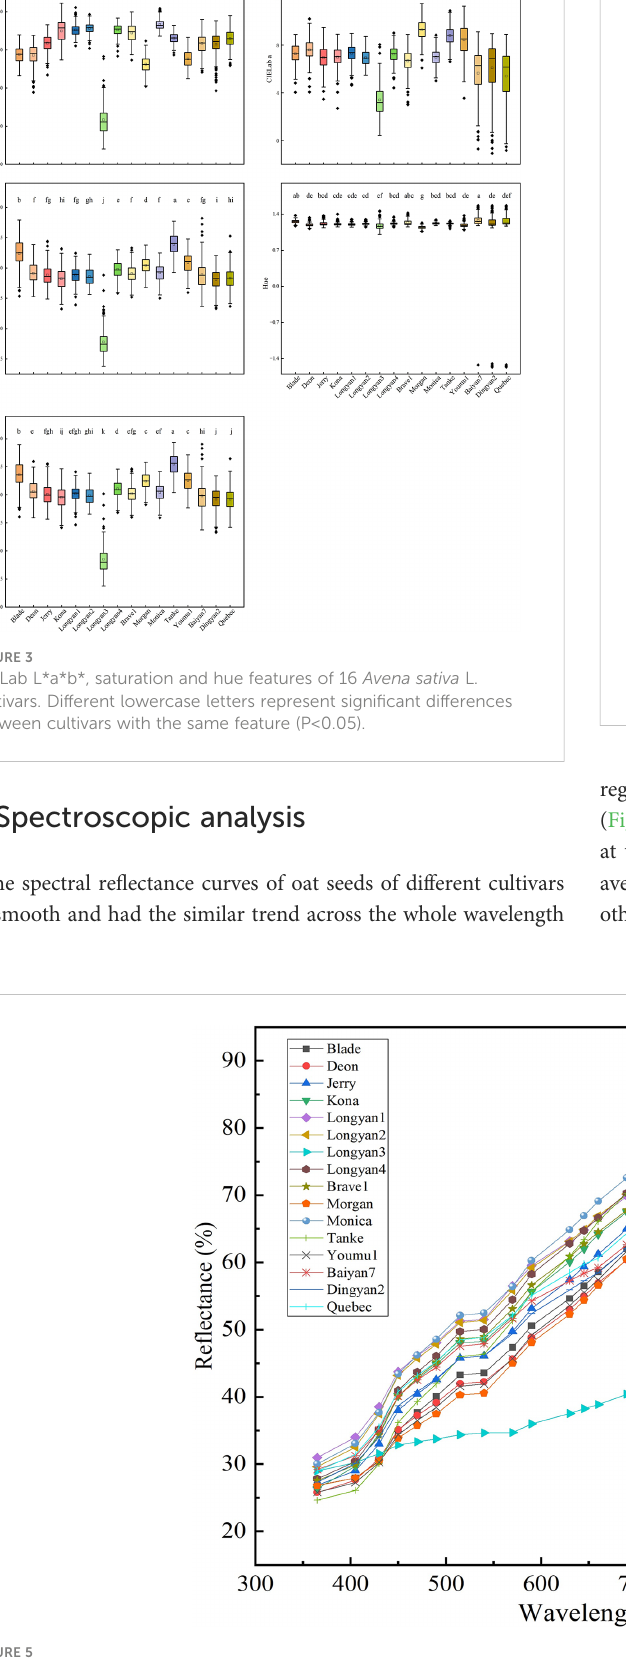
FIGURE 5 Mean light re fl ectance (%) of 19 wavelengths (nm) in 16 Avena sativa L. cultivars.